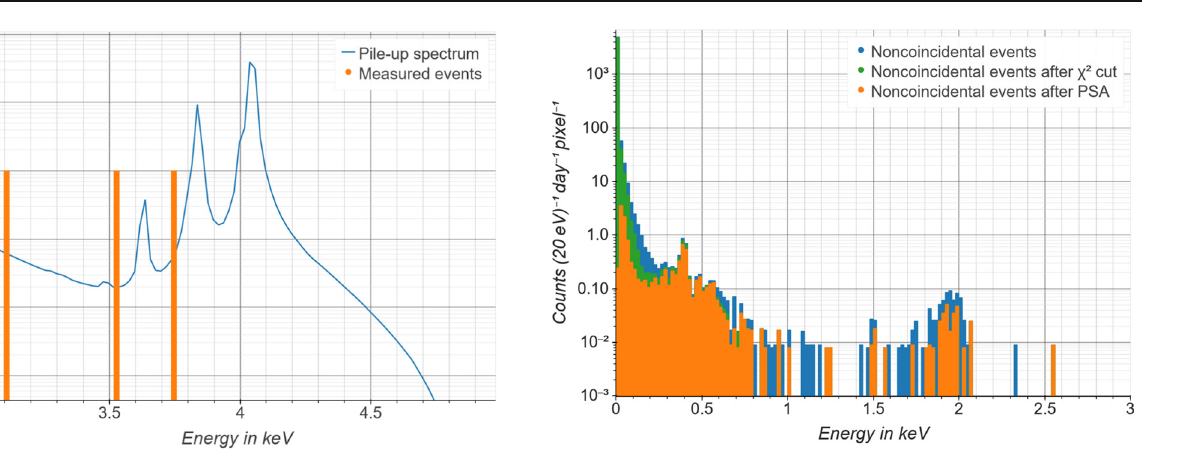
ration [16], resulting in a fraction of 166 m Ho/ 163 Ho < 10 − 9